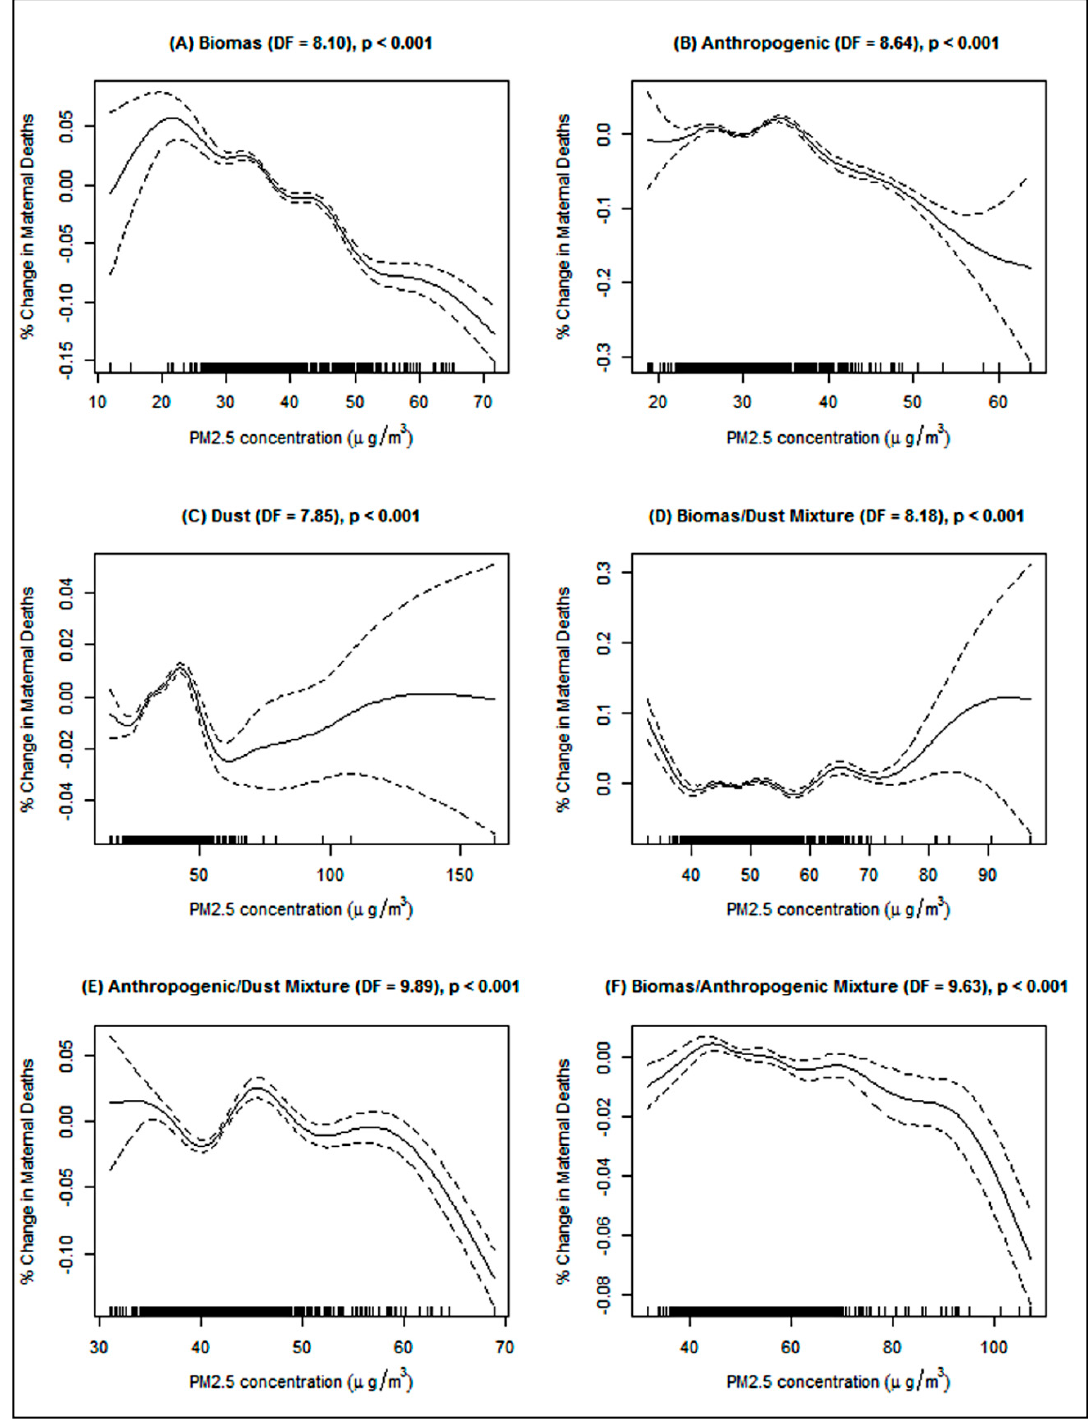
Figure 4. Penalized spline of the association between ambient PM 2.5 concentration and maternal deaths